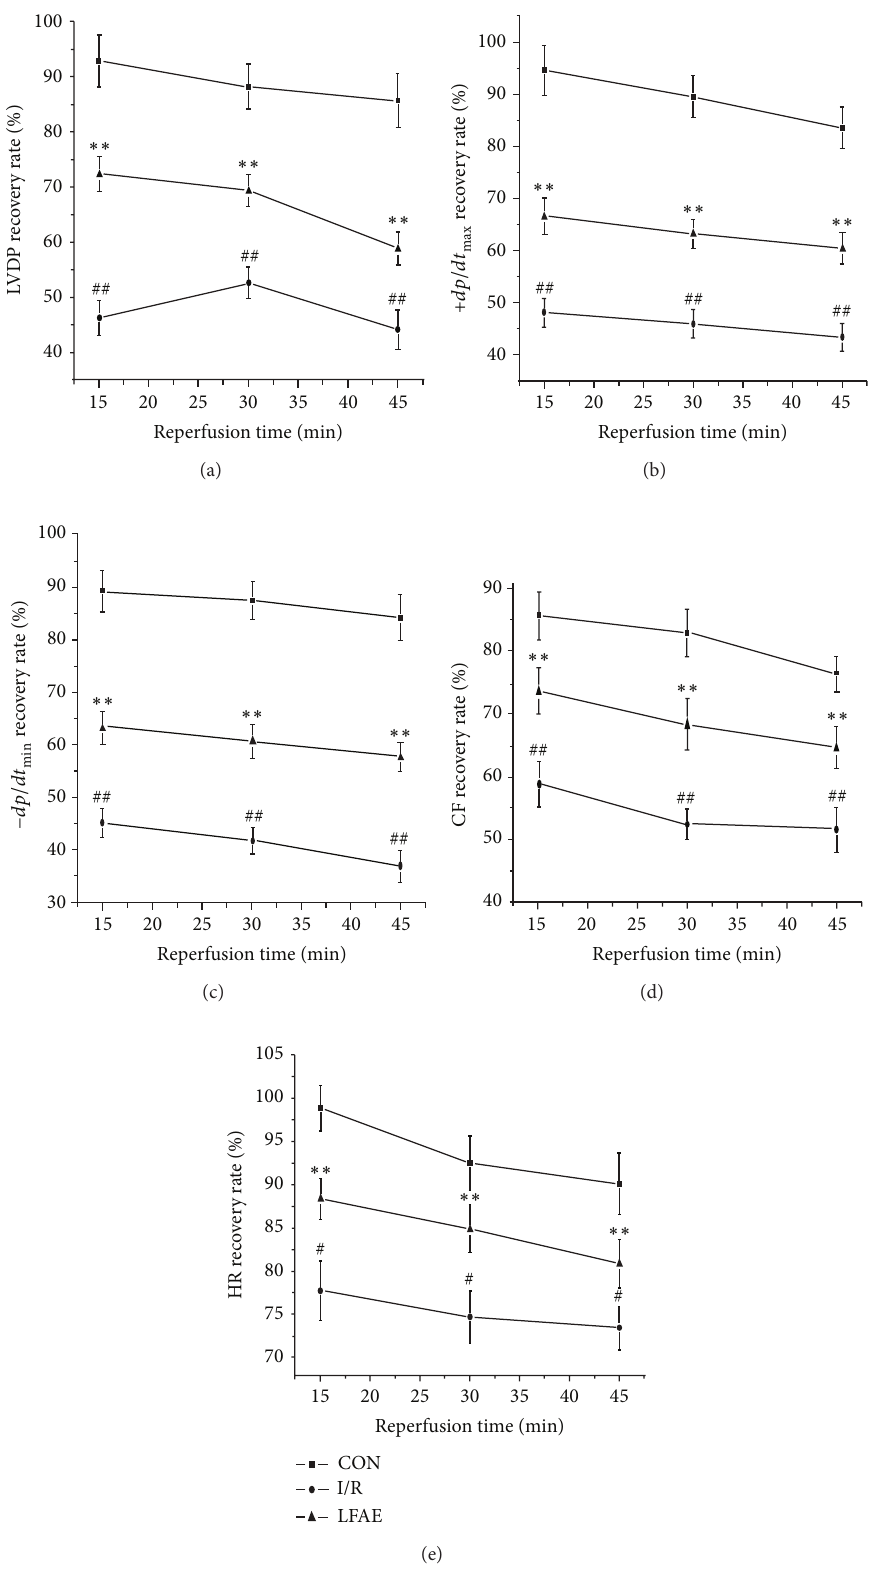
Figure 1: Effect of LFAE on cardiac function (LVDP, +𝑑𝑝/𝑑𝑡 max , −𝑑𝑝/𝑑𝑡 min , CF, HR) in rats subjected to I/R ( 𝑥 ± 𝑠 , %, 𝑛 = 8 ). ∗∗ 𝑃 < 0.01 , compared with control group; ## 𝑃 < 0.01 , compared with I/R group. CON: control group (Sham), I/R: I/R group, and LFAE: aqueous extract of lavender flower treatment